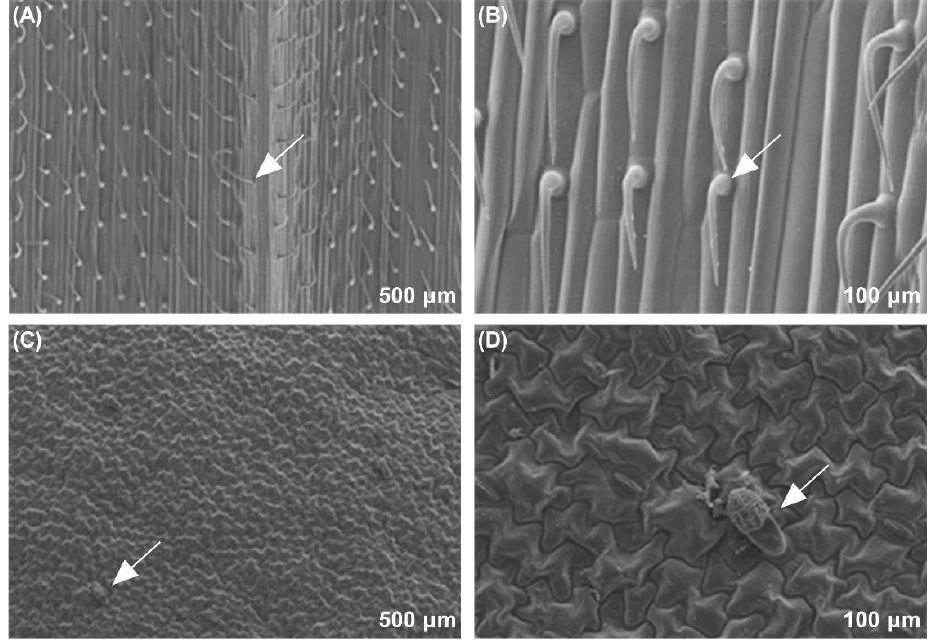
Figure 6. Scanning electron microscope (SEM) observations of the epidermal characteristics of wheat and faba bean leaves. The adaxial and abaxial surfaces of wheat leaves ( A , B ) and adaxial and abaxial surfaces of faba bean leaves ( C , D ). The arrow in the figures indicates the shape of the trichomes in the field of view.